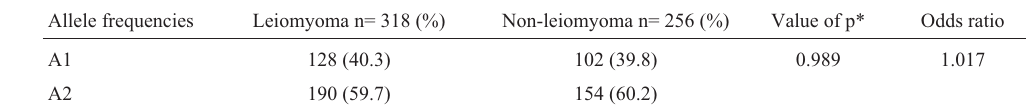
*Values of p were calculated by χ 2